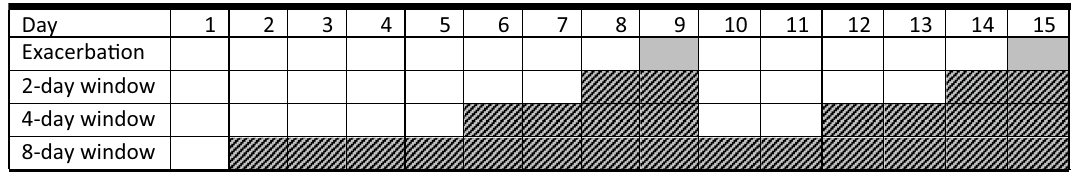
Table 4. Definition of the outcome variable. This is a hypothetical example of the definition of the outcome variable over 15 days of measurement. The patient experiences an exacerbation at day 9 and day 15.